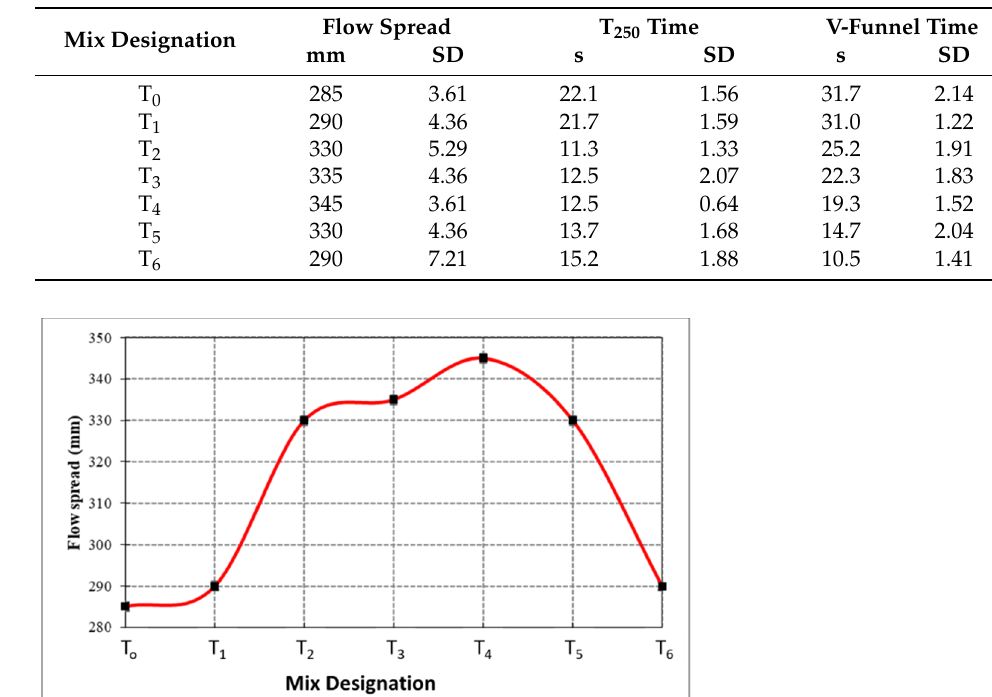
Table 3. Total flow spread, T250 time, and V-funnel times.